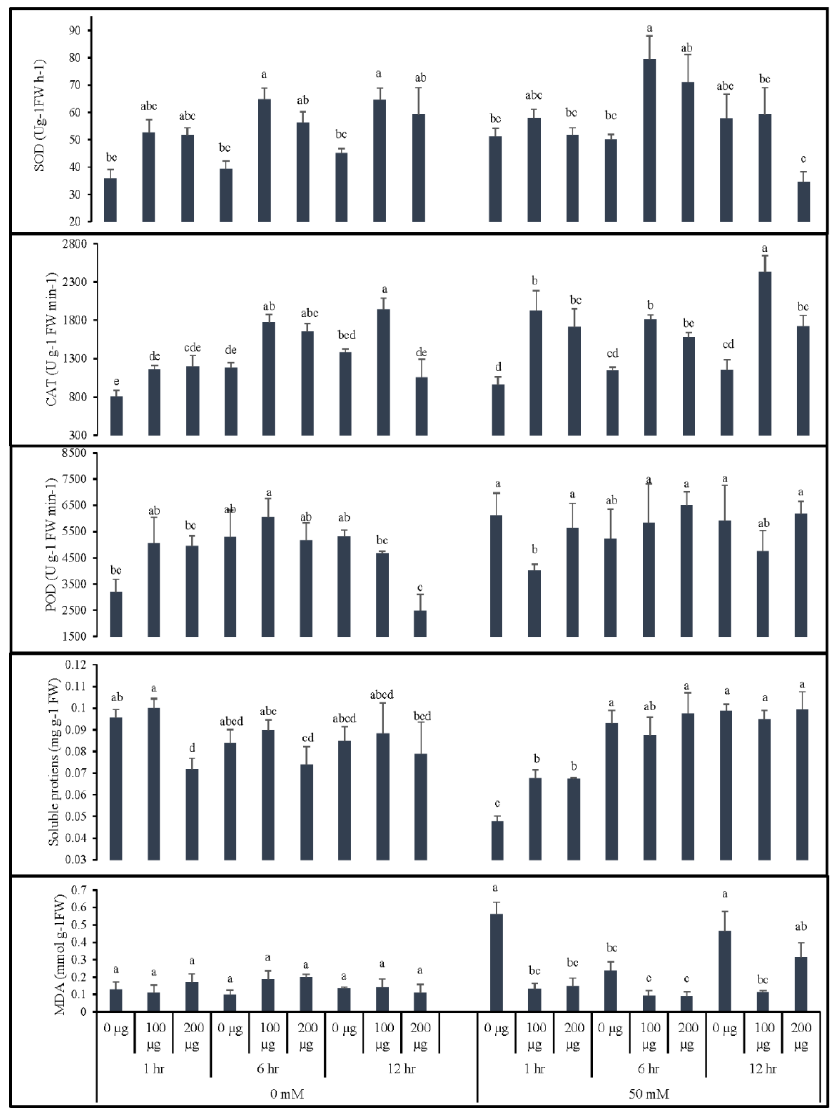
Figure 4. Effect of AGE priming on the antioxidant enzyme activities, lipid peroxidation, and soluble protein abundance of tomato. Primed seeds were germinated under 0 and 50 mM NaCl stress. Data for antioxidant enzyme activities of catalase (CAT), peroxidase (POD), and superoxide dismutase (SOD), malondialdehyde content (MDA), and soluble protein abundance are presented as means + standard errors (bars). All data were subjected to factorial ANOVA and post hoc Tukey’s honestly significance difference (HSD) at p = 0.05. Means followed by the same letters bear no statistical difference.